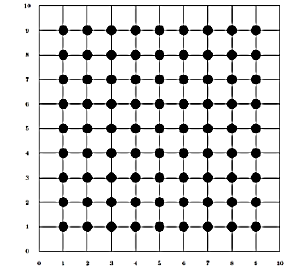
Fig. 1. Configuration space nodes in grid-shaped.